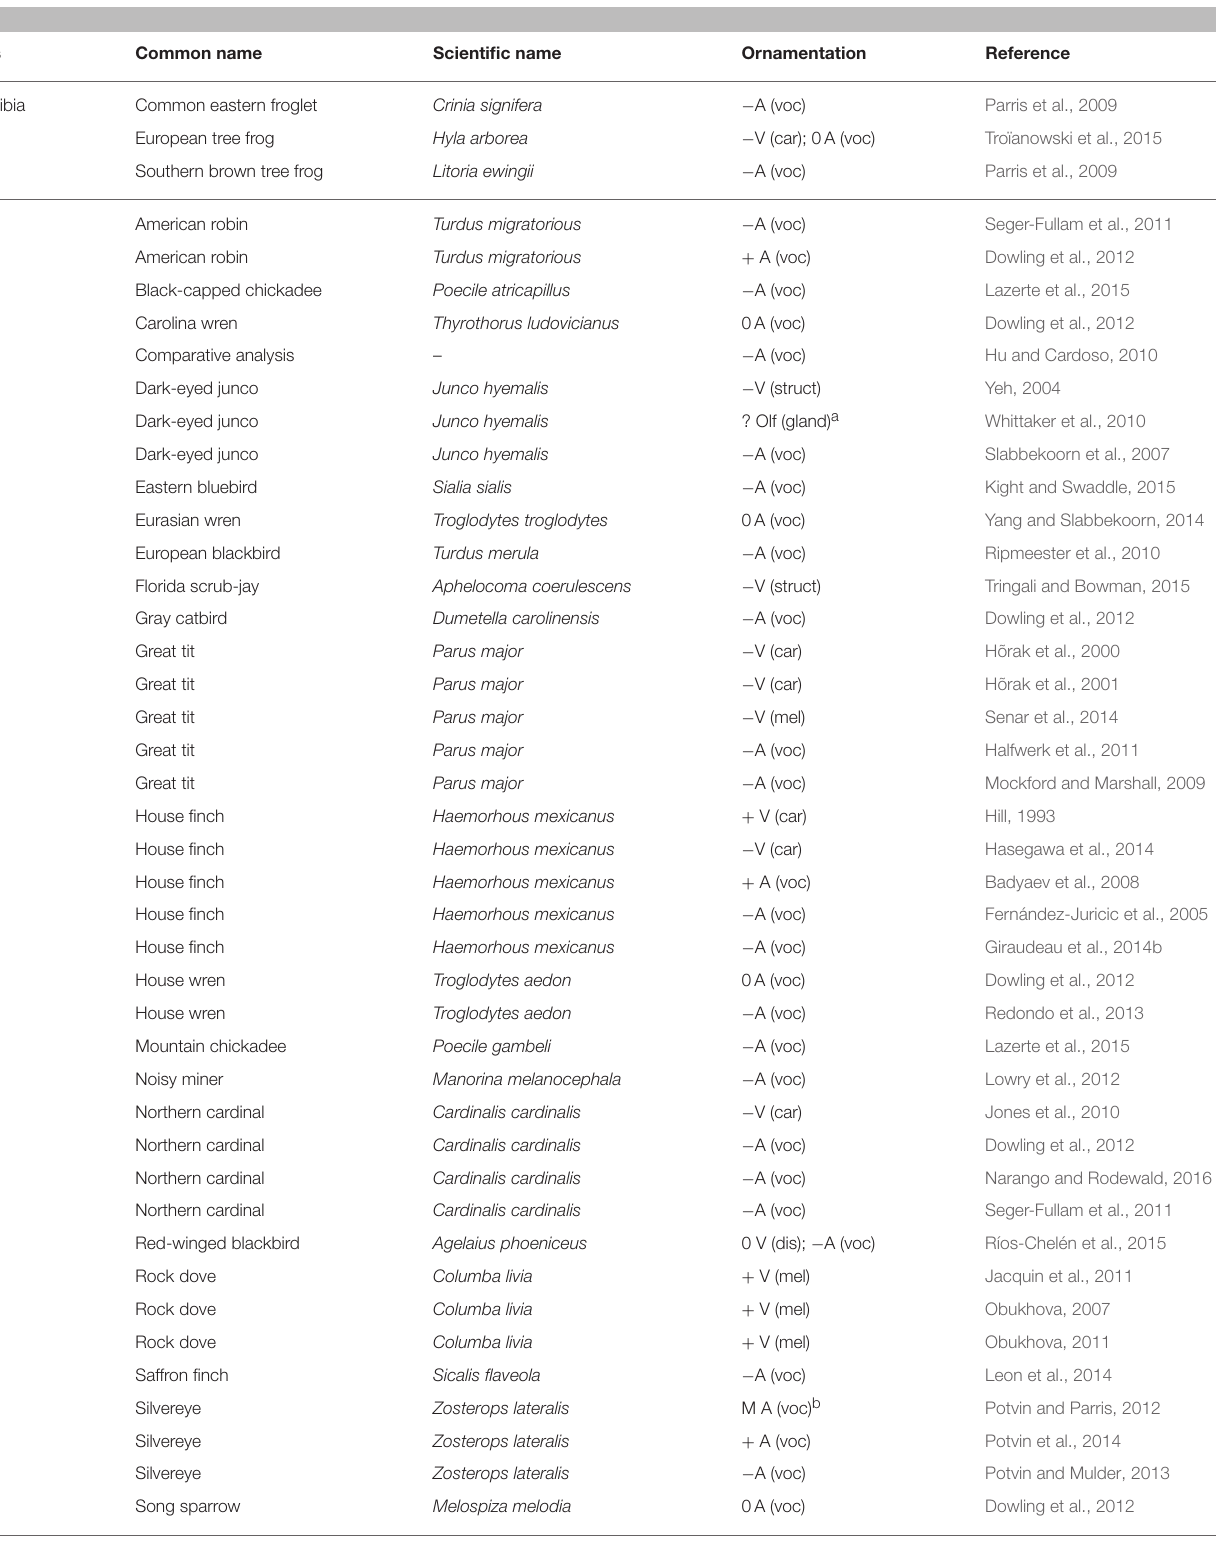
TABLE 1 | Summary of studies that associate urbanization with (A) animal signals, (B) both animal signals and oxidative stress and/or antioxidants, and (C) just oxidative stress and/or antioxidants.